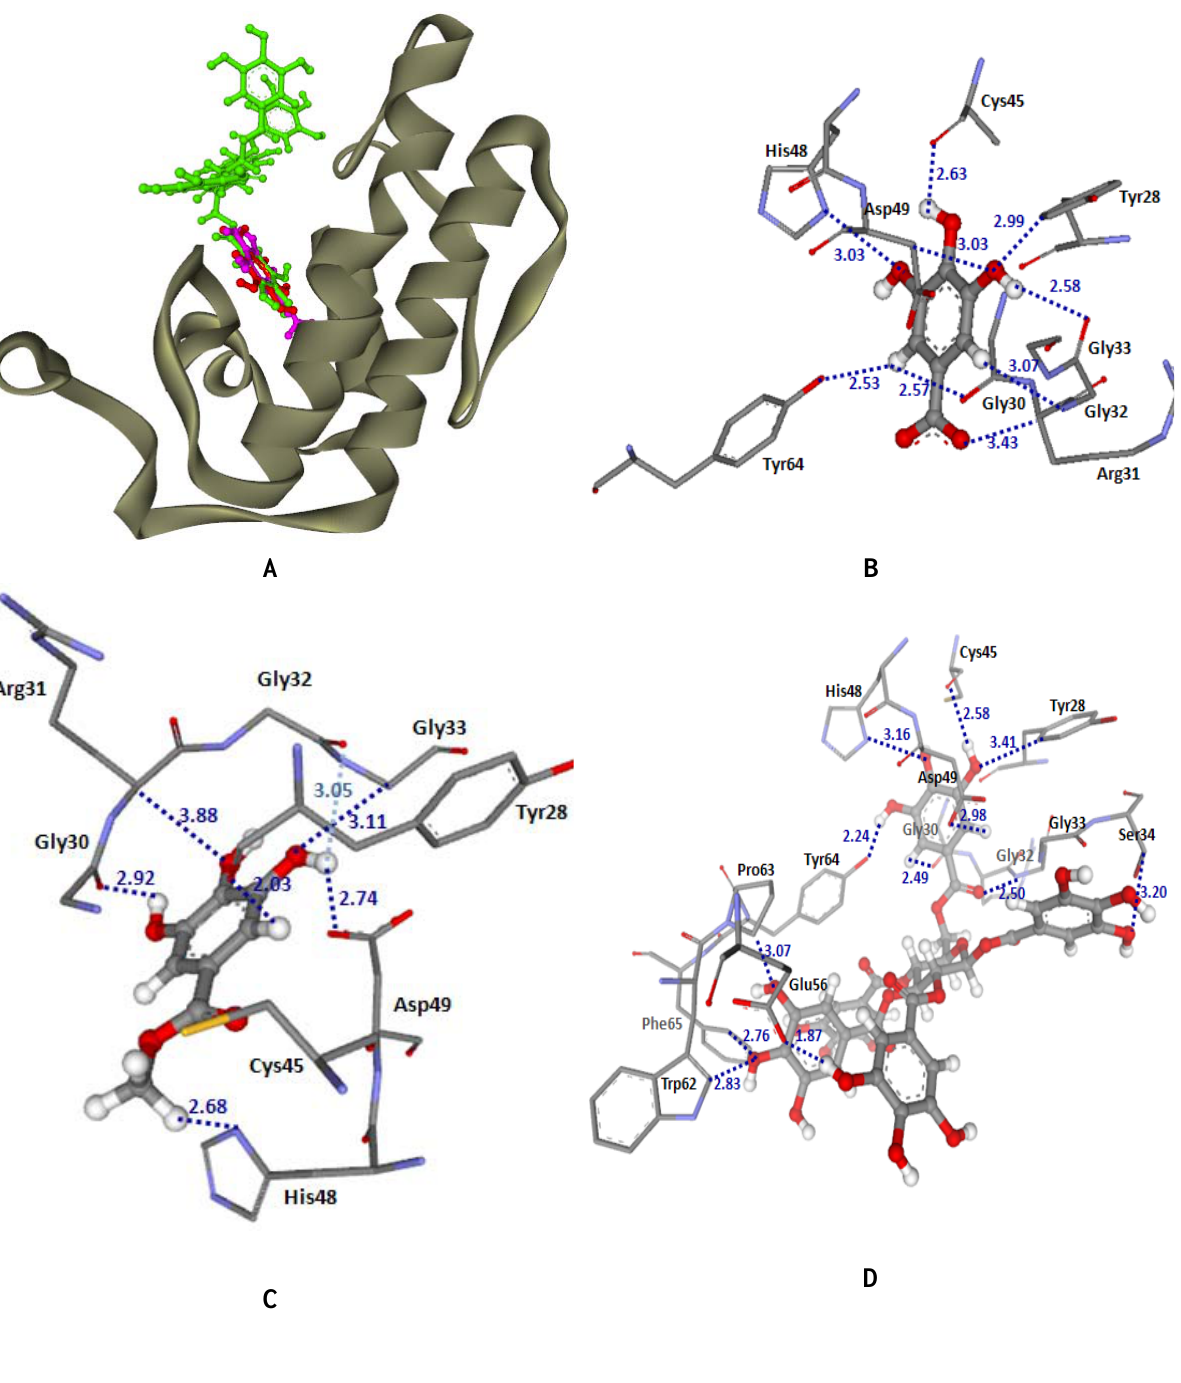
Figure 6 . (A) Docked conformation of ligand structures in PLA MG: Margenta and PGG: Green). (B-D) Distances (in Å) between residues in PLA binding pocket and ligands: GA (B), MG (C) and PGG